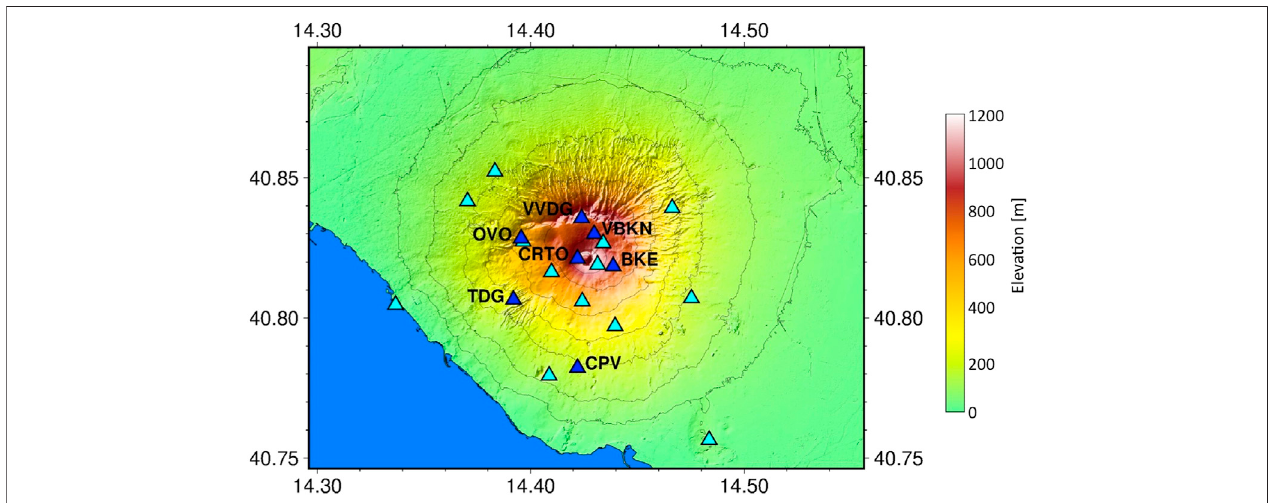
FIGURE 2 | Map of Vesuvius seismic network. The triangles are the seismic stations. The blue ones with labels are the stations used to locate a long-period transient (LP) recorded on November 16, 2020. The label is also shown for OVO station, which is installed in the historical building of the Osservatorio Vesuviano and is the reference for the seismic catalog of